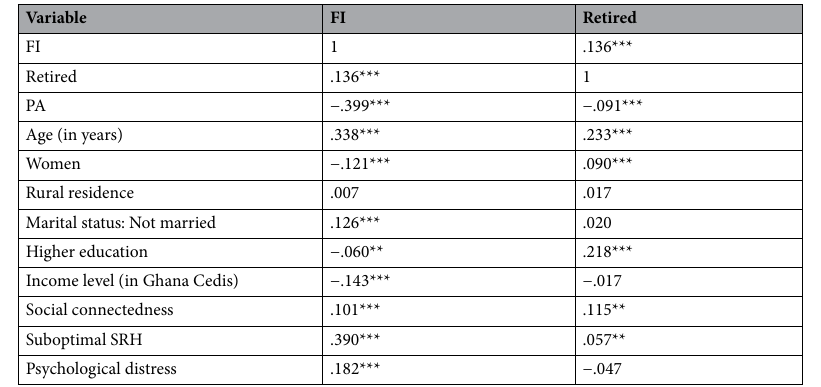
Table 3. Correlations between the independent and dependent variables of interest. Pearson product-moment correlations were used to calculate the association between continuous variables, point-biserial correlations were used to assess the relationship between continuous and dichotomous variables, and phi correlations were used to assess the relationship between dichotomous variables. FI—functional impairment; AP—physical activity; SRH—self-rated health.